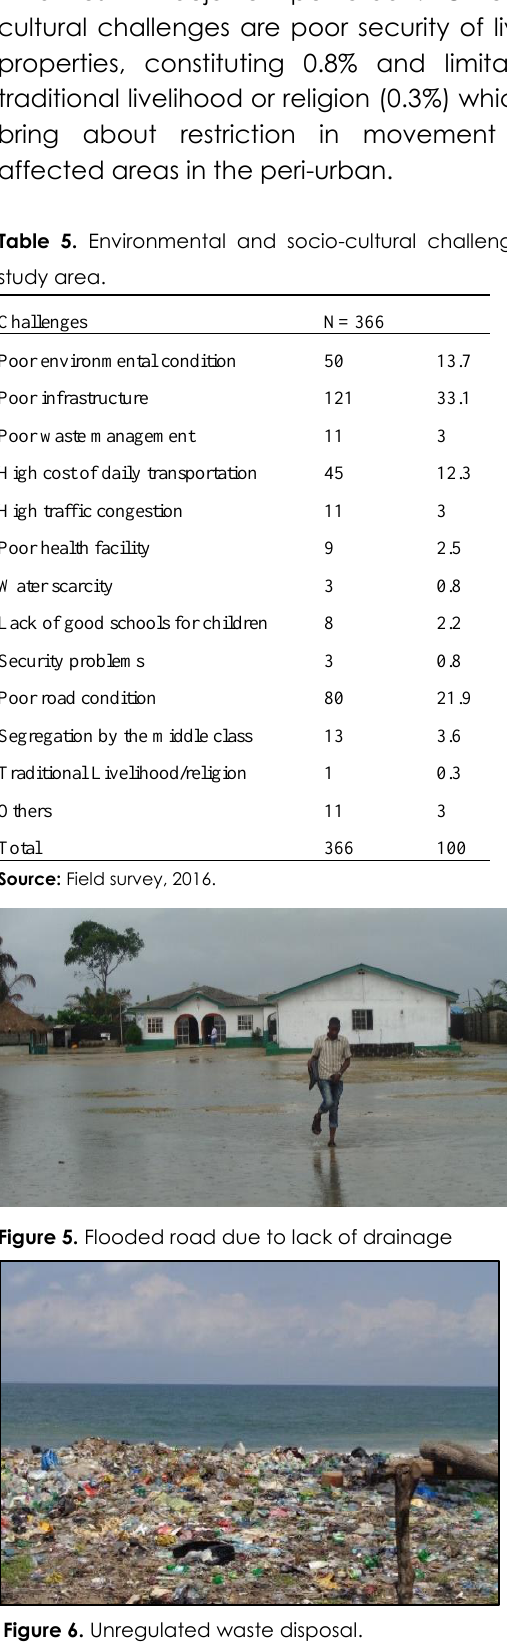
Figure 6. Unregulated waste